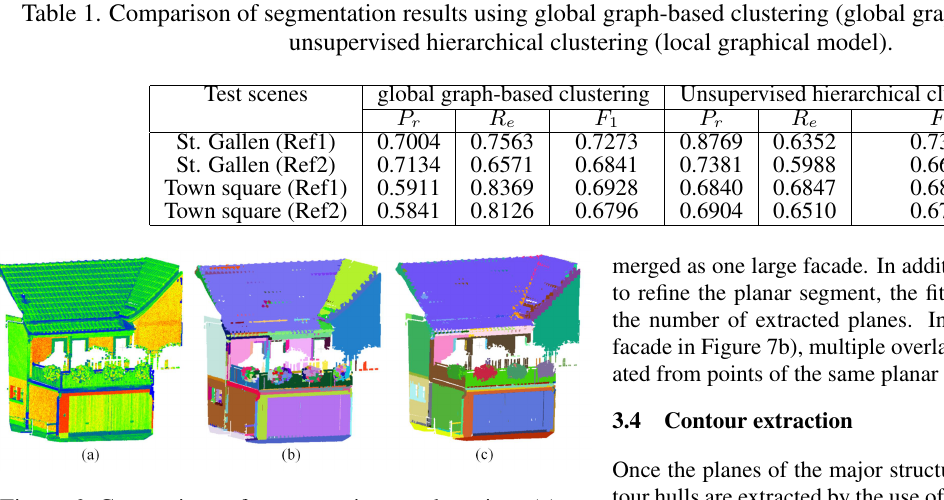
Figure 6. Comparison of segmentation results using. (a) Original point clouds, (b) segmentation results using method from (Xu et al., 2018b), and (c) segmentation results using voxel-based global graph-based clustering.